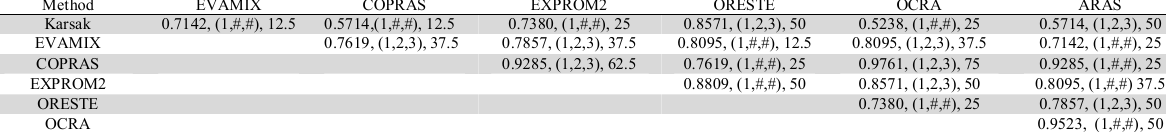
A comparative study on ranking performance for six preference ranking methods